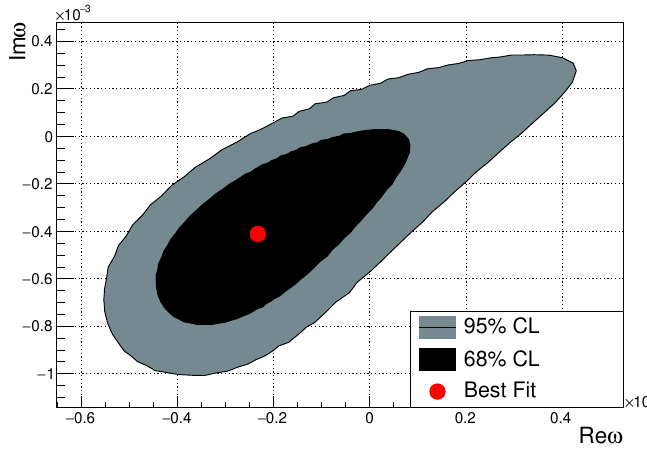
Figure 5 . Contour plot of = ω vs. < ω for 68% and 95% confidence levels.